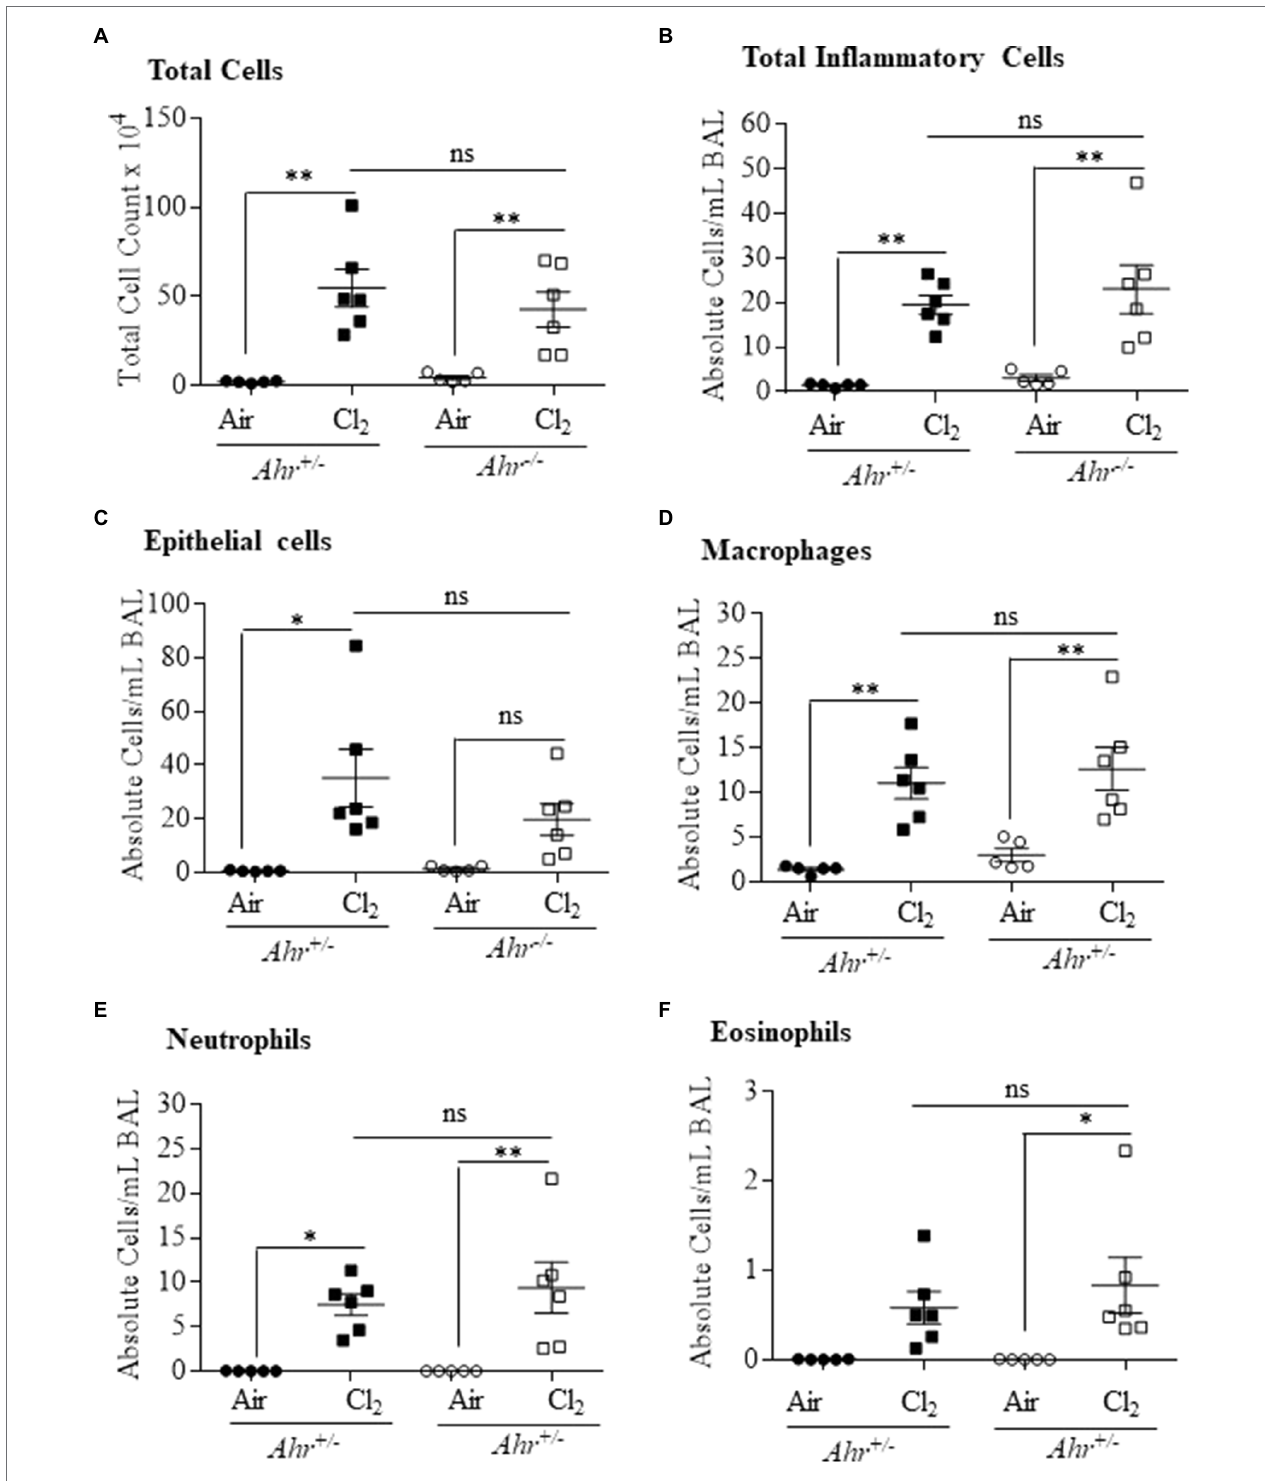
FIGURE 6 | Aryl hydrocarbon receptor does not control chlorine (Cl 2 )-induced airway inflammation. Total and differential cell counts of the BAL of Ahr+/ − and Ahr − / − was evaluated 24 h after exposure to Cl 2. There was a significant increase in total cells (A) , total inflammatory cells (* p = 0.0023; B ), epithelial cells (* p = 0.06001; C ), macrophages ** p = 0.0039 (D) and neutrophils (* p = 0.0297; ** p = 0.0055; E ) and eosinophils (* p = 0.0402; F ) in mice exposed to Cl 2 compared with the control mice. There was no significant difference (ns) between the Ahr+/ − and Ahr − / − mice. Results are expressed as the mean ± SEM; values for individual female mice are